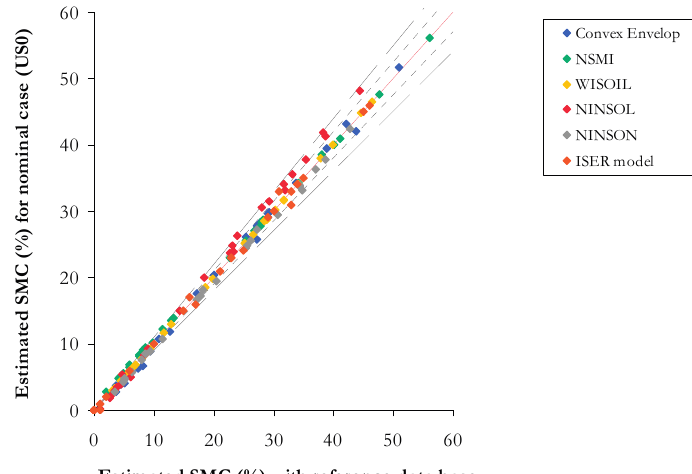
Figure 10. Spectral indices (NSMI, WISOIL, NINSOL, NINSON) and general shape methods (convex envelope, ISER model—Representation of the SMC computed on the simulated spectra (nominal case US0) according to SMC estimated on the corresponding measured spectra (point lines on each side of the central line give the limit of an error of 5% and the long-dashed lines an error of 10%).